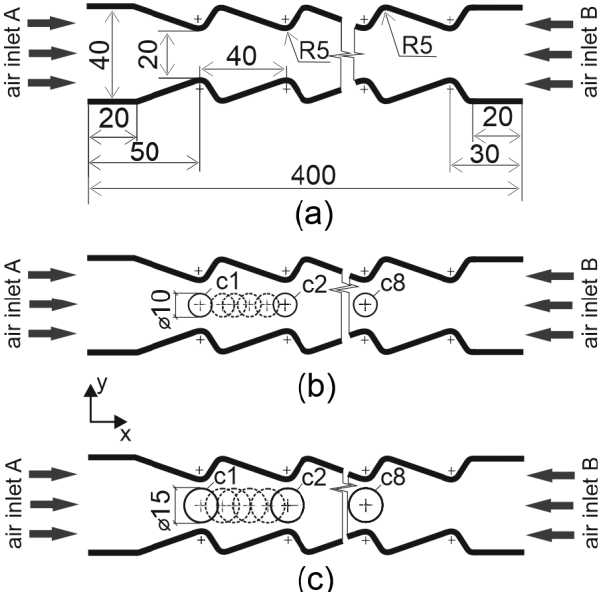
Figure 1. Geometric dimensions of the examined configurations ( a ) wavy channel A (WCA) and wavy channel B (WCB), ( b ) wavy channel A with CVGs diameter of 10 mm (WCCA10) and wavy channel B with CVGs diameter of 10 mm (WCCB10), ( c ) wavy channel A with CVGs diameter of 15 mm (WCCA15) and wavy channel B with CVGs diameter of 15 mm (WCCB15). The configurations of the examined channels are shown in Table 1. For the sake of clarity, the investigated configurations are defined by the abbreviations. The wavy